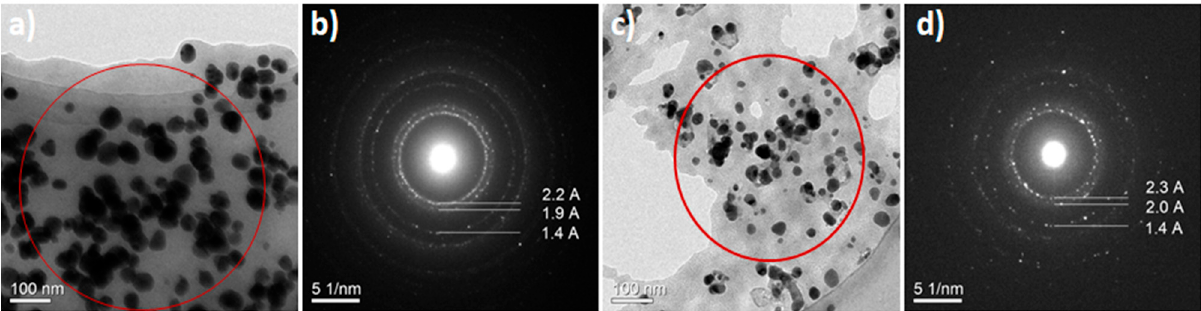
Figure 8. ( b , d ) Selected area for electron diffraction (SAED) patterns showing rings corresponding to the crystal planes of AgNPs structure. ( a , c ) Bright-field transmission electron microscopy (BF-TEM). The SAED patterns recorded at nominal camera length 1000 mm.